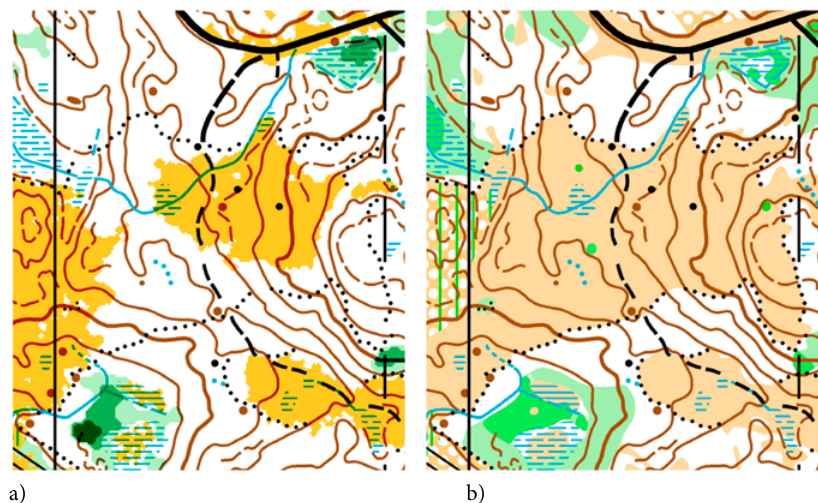
Fig. 10. New clear cuts have been made between the lidar acquisition (2010) and the manual survey (2013). (a) The new clear cuts are missed by the automatic method. (b) They are mapped by the manual survey